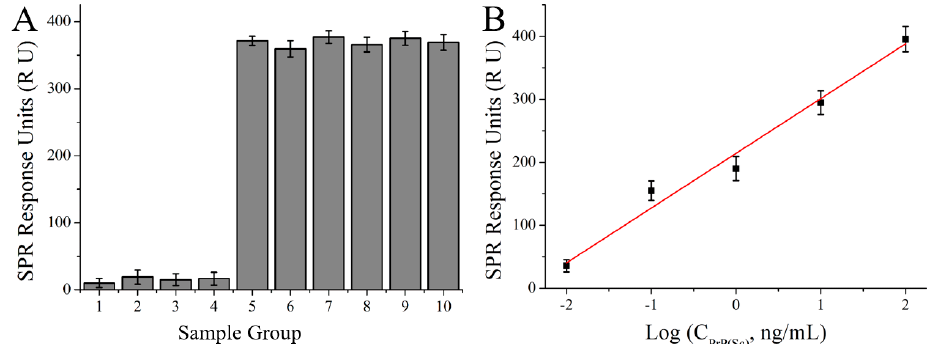
Figure 7. ( A ) Specific analysis of MMs involved SPR amplification detection. 1–4: MPA, thioPEG, Cys-protein G and PrP C (50 ng/mL each) in PBS buffer, respectively; 5: PrP Sc (50 ng/mL) in PBS buffer; 6: PrP Sc (50 ng/mL) in NBCS; 7–10: Mixture of PrP Sc (50 ng/mL) and each of the four different reagents (50 ng/mL) in PBS buffer. ( B ) Calibration curve of MMs involved SPR detection assay for PrP Sc in human serum.